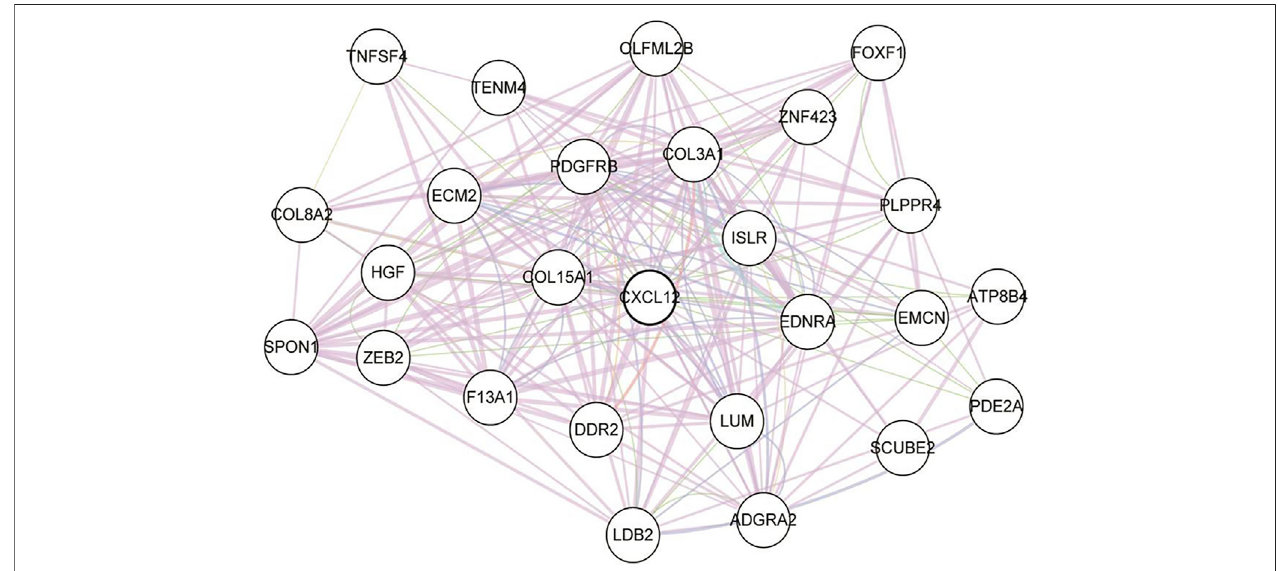
FIGURE3| Theprotein-proteininteractiongraphoftheCXCL12module.Nodesrepresentproteins,andlinesrepresentthepossiblerelationships.CXCL12:C-X-C motif chemokine ligand 12.